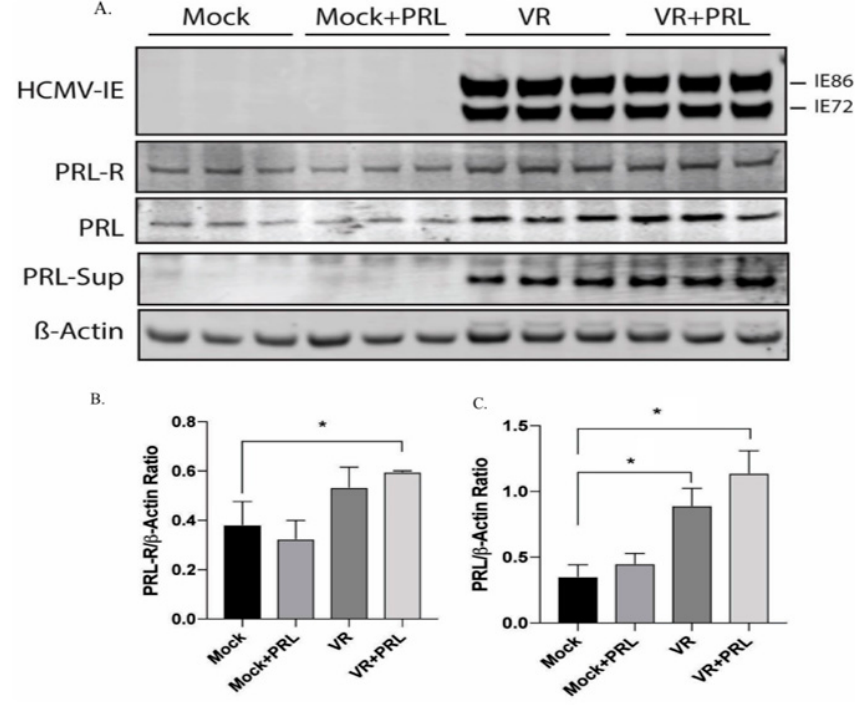
Figure 3. Increased protein levels of PRL and PRLR in HCMV-infected SKOV3 cells. HCMV-IE, PRLR, and PRL proteins were detected in untreated and PRL-treated (200 ng / mL) uninfected and HCMV-infected SKOV3 cells by Western blot assay. ( A ) PRL was detected in cell culture media derived from infected and uninfected cells after protein precipitation. ( A – C ) Both PRL and PRLR proteins were significantly increased in HCMV-infected cells treated with PRL. ( C ) PRL was detected in HCMV-infected cells without PRL treatment. Results are representative of three separate experiments. Data is presented as mean ± SD ( n = 3). Statistical significance is indicated as * P < 0.05.